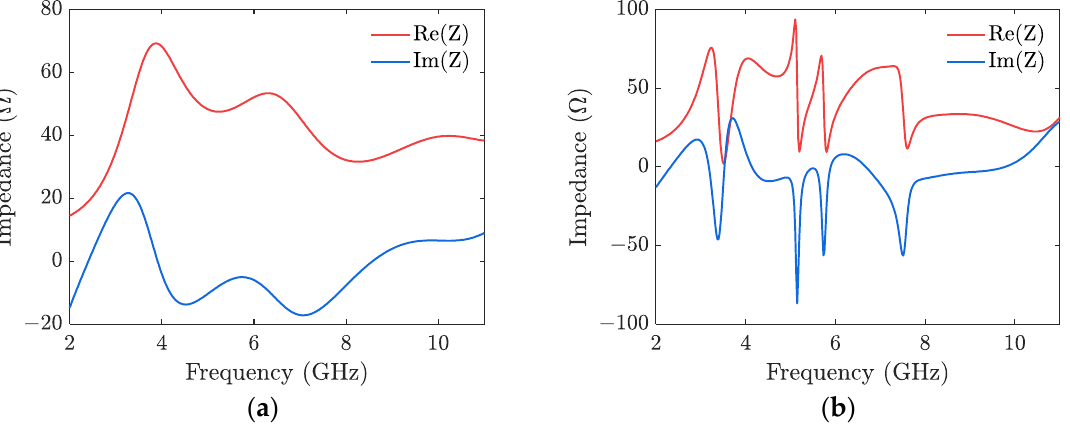
Figure 6. Simulated impedance characteristics of the proposed antennas. ( a ) Without band notch structures. ( b ) With band notch structures.